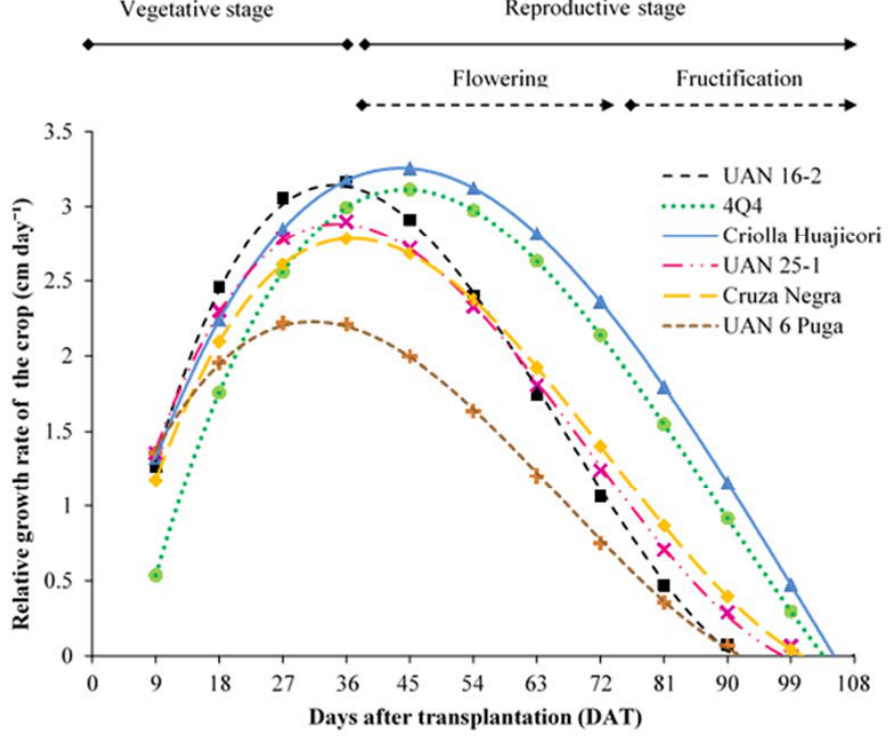
Figure 1. Relative growth rate of the crop (RGRC) of roselle cultivars as a function of time. Estimated values from models (Table 1).